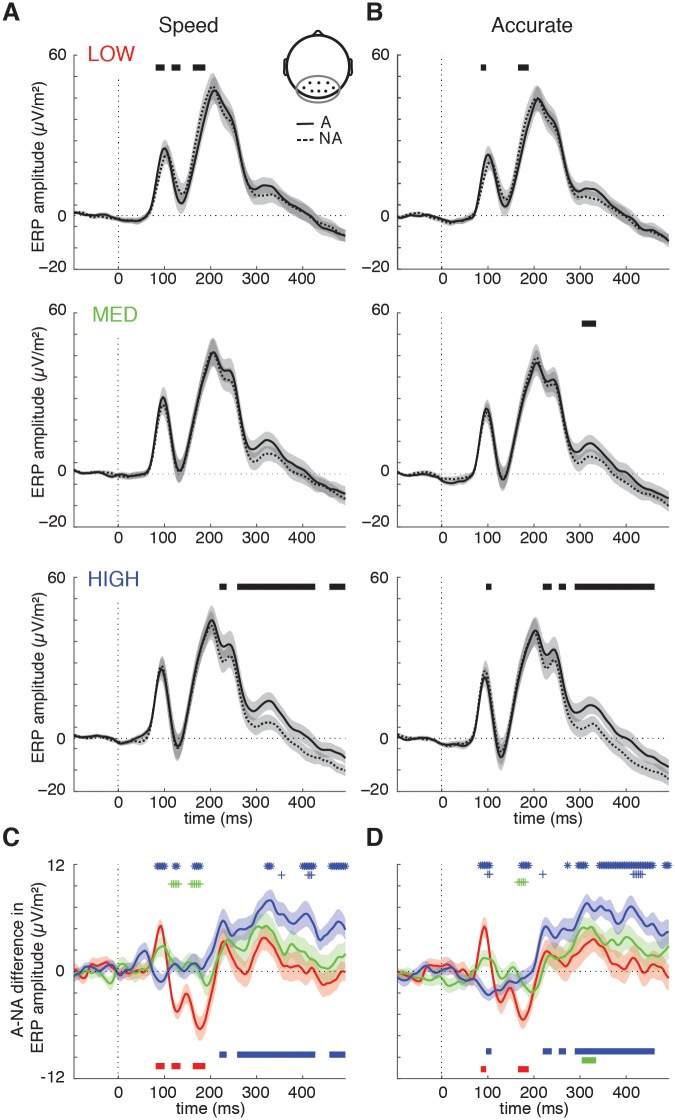
ERP results from the EEG experiment (Experiment 2).Average ERP amplitude for animal (solid lines) and non-animal scenes (dashed lines) per condition for an occipital-peri-occipital cluster of EEG channels (Oz, POz, O1, O2, PO3, PO4, PO7, PO8) for the A) speed and B) accuracy trials. Shaded regions indicate SEM across participants. Significant differences between animal and non-animal ERPs (FDR-corrected) are indicated with thick black lines (also in C/D). C-D Animal vs. non-animal difference wave for each condition overlaid and statistically compared (FDR-corrected) for the speed A) and accuracy B) trials. Thick lines at the bottom of the graphs indicate significant difference wave deflections from zero, and shadings indicate S.E.M. Symbol markers indicate significant differences in difference wave amplitude between conditions, blue asterisk: HIGH vs. LOW; blue plus: HIGH vs. MEDIUM; green plus: MEDIUM vs. LOW.